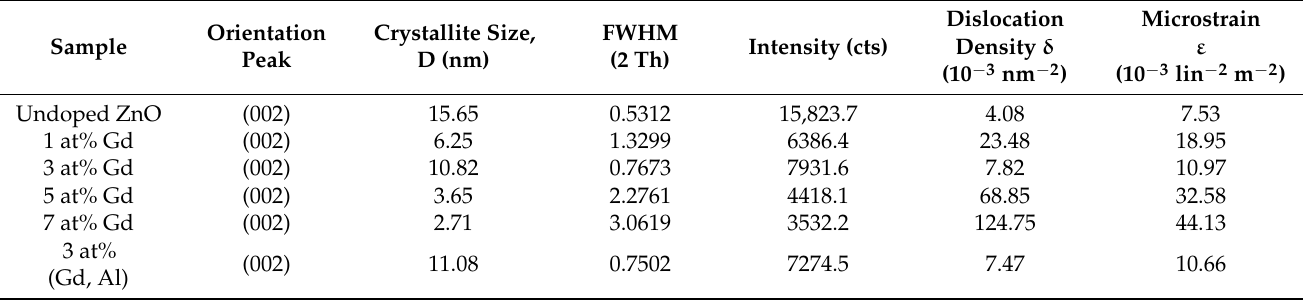
Figure 2. XRD spectra of ( a ) undoped ZnO and Gd-doped ZnO films at various Gd concentrations, ( b ) 3 at% Gd-doped ZnO films and 3 at% (Gd, Al) co-doped ZnO films. Table 1. Structural properties of undoped ZnO, Gd-doped ZnO films, and 3 at% (Gd, Al) co-doped ZnO